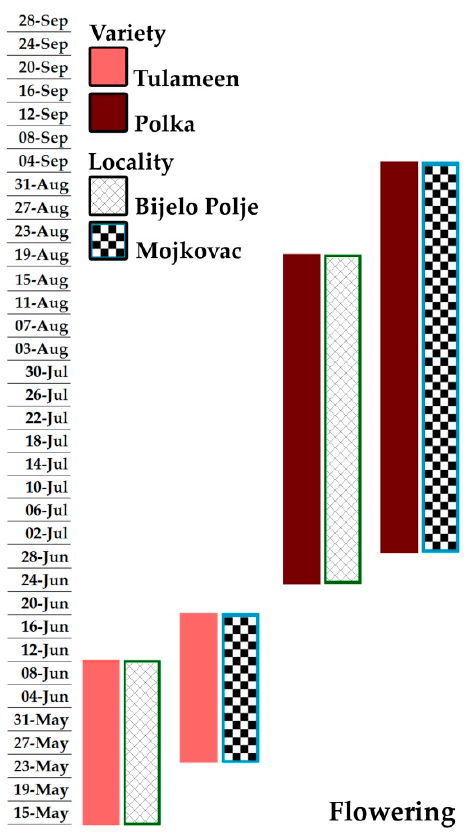
Figure 4. Flowering phenophase of the Polka and Tulameen varieties in the localities Bijelo Polje and Mojkovac—Montenegro (average, years 2018/2019).